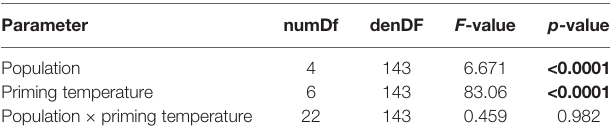
TABLE 1 | Two-way ANOVA to assess the effects of priming temperature and population on integrated survival of Laminaria digitata gametophytes over time in experiment